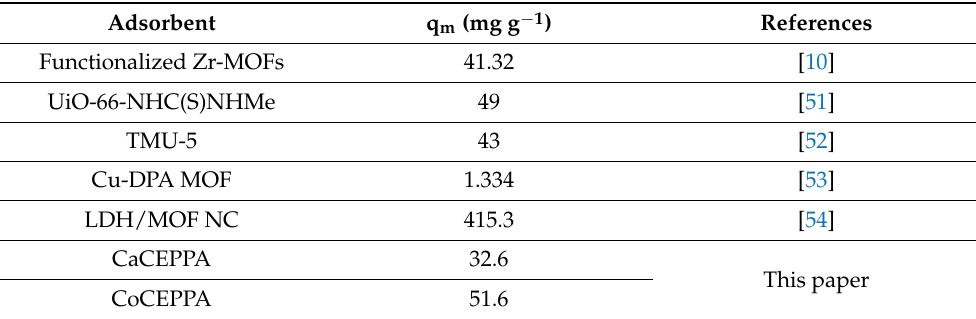
Table 3. Comparison of the maximum adsorption capacities given/demonstrated by similar adsor- bents in the treatment process of aqueous solutions containing Cd 2+ ions.